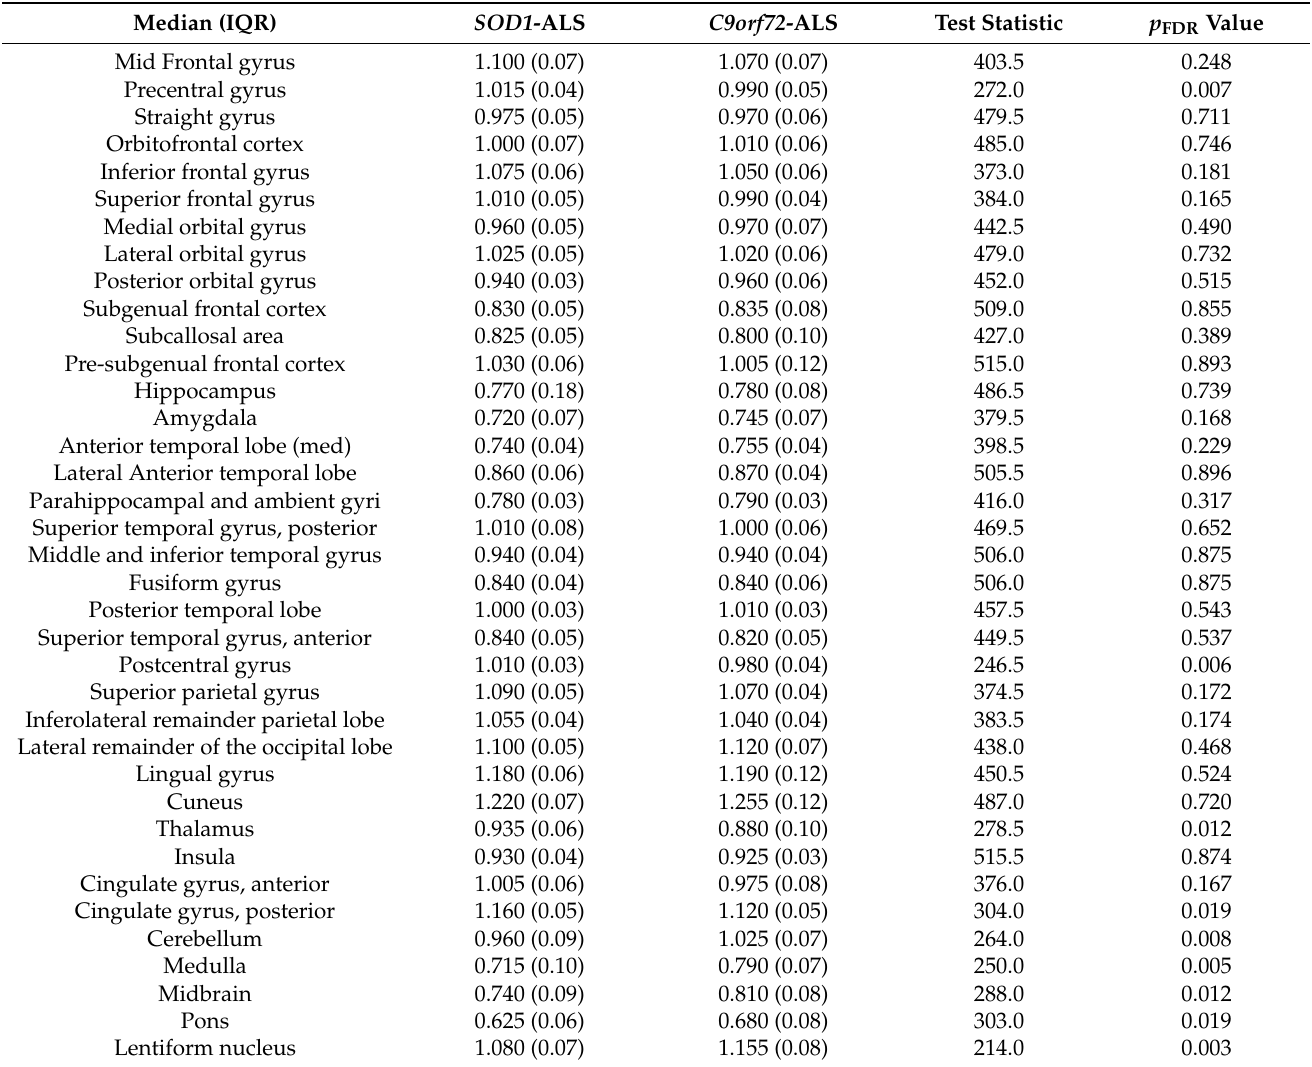
Table 2. Volume-of-interest (VOI)-based Mann–Whitney U test of 18 F-FDG SUVR between SOD1 -ALS ( n = 22) and C9orf72 -ALS patients; n = 48). FDR-corrected p -values < 0.05 for multiple testing were considered significant. Abbreviations: IQR, interquartile range; Md, median; sALS = sporadic ALS; SOD1-ALS = SOD1-associated ALS; SUVR = standardized uptake value